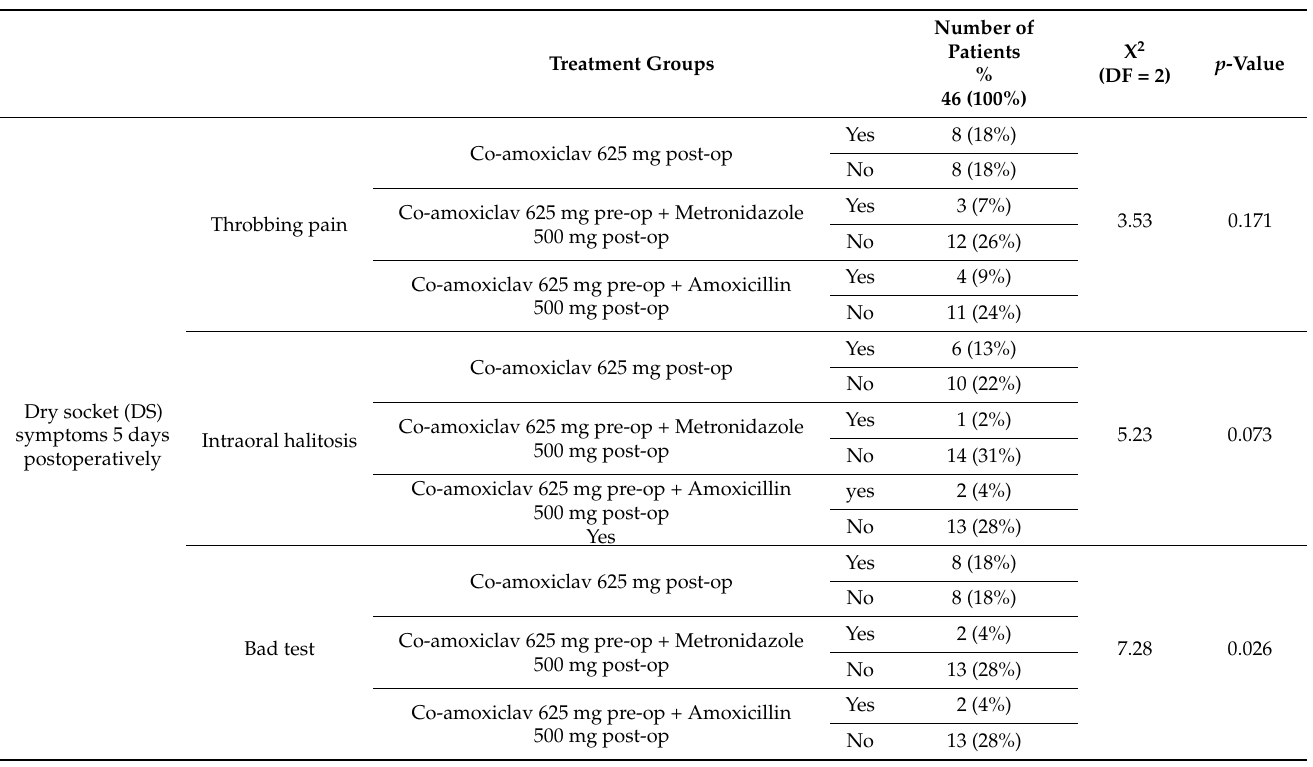
Table 2. Comparisons between different regimens of oral antibiotics and dry socket symptoms occurrence.